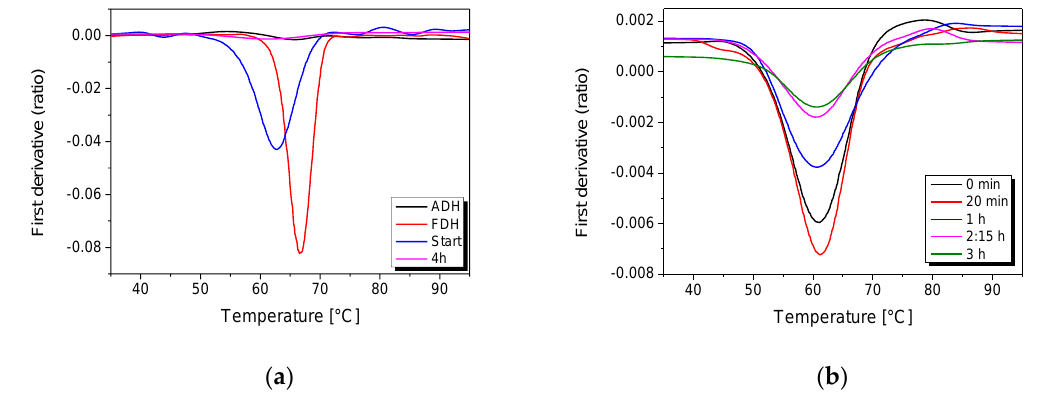
Figure 4. Measurement of protein stability by differential scanning fluorimetry. ( a ) Crude enzymes in comparison to start and end point of a reaction. ( b ) Reaction progress over 3 h. Conditions: potassium phosphate buffer pH 8, 0.1 M, V = 25 mL, c Aldehyde = 7.5 mM, c NADH = 0.15 mM, m ADH = 0.5 mg, m FDH = 5 mg, c sodium formate = 100 mM, 30 °C.